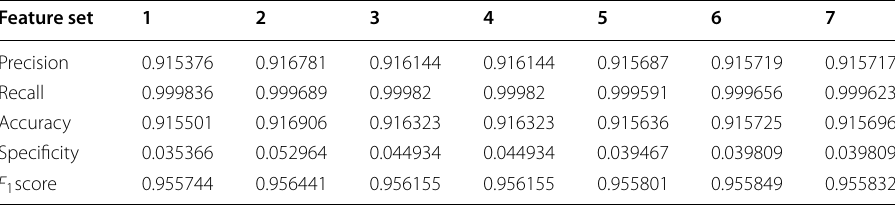
Table 3 Results of neural network